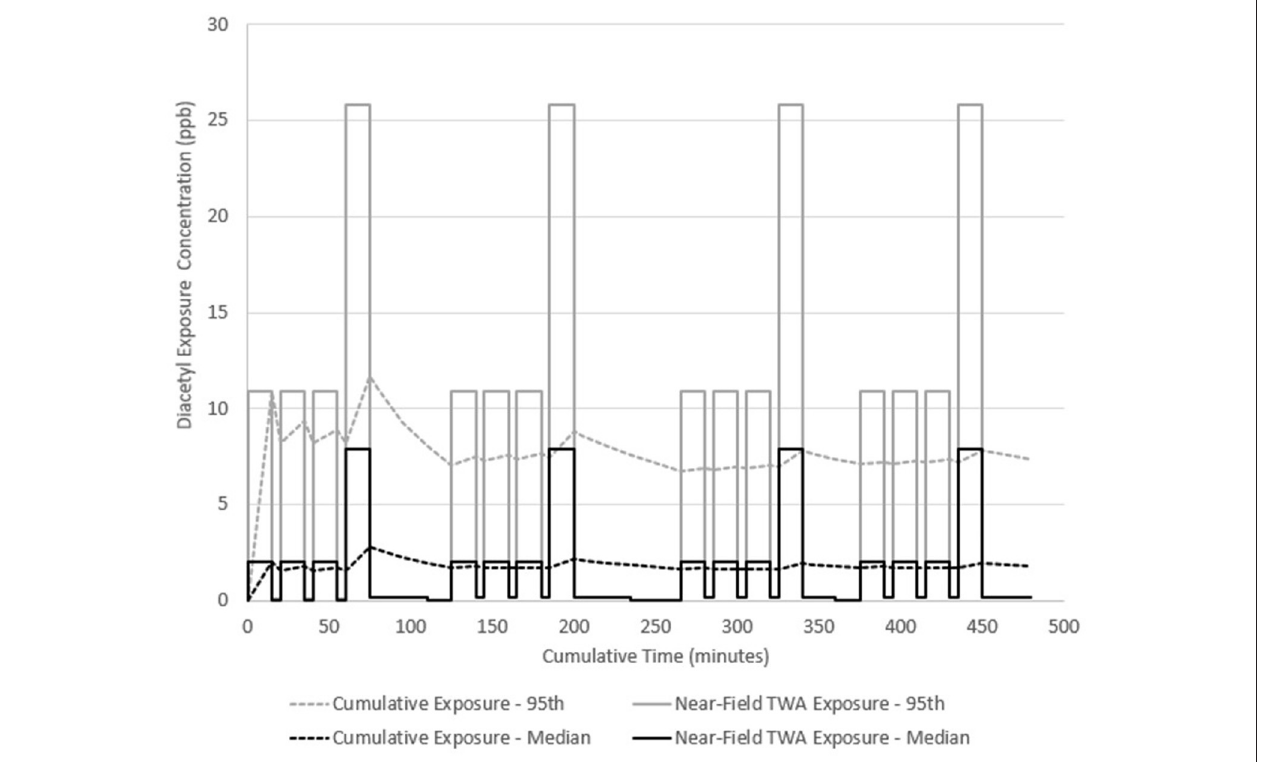
FIGURE 3 | Diacetyl cumulative exposure profile for a general production worker (Scenario A). NIOSH REL 5.0 ppb for diacetyl.